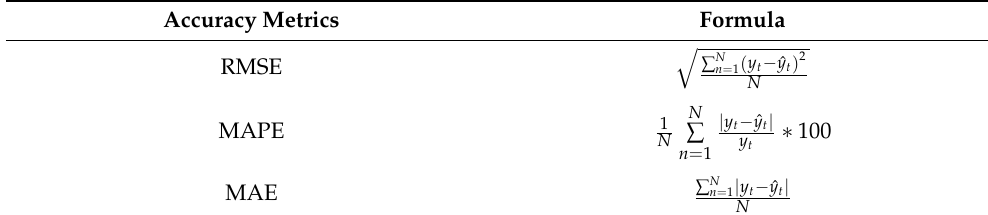
Table 1. The mathematical formula for each